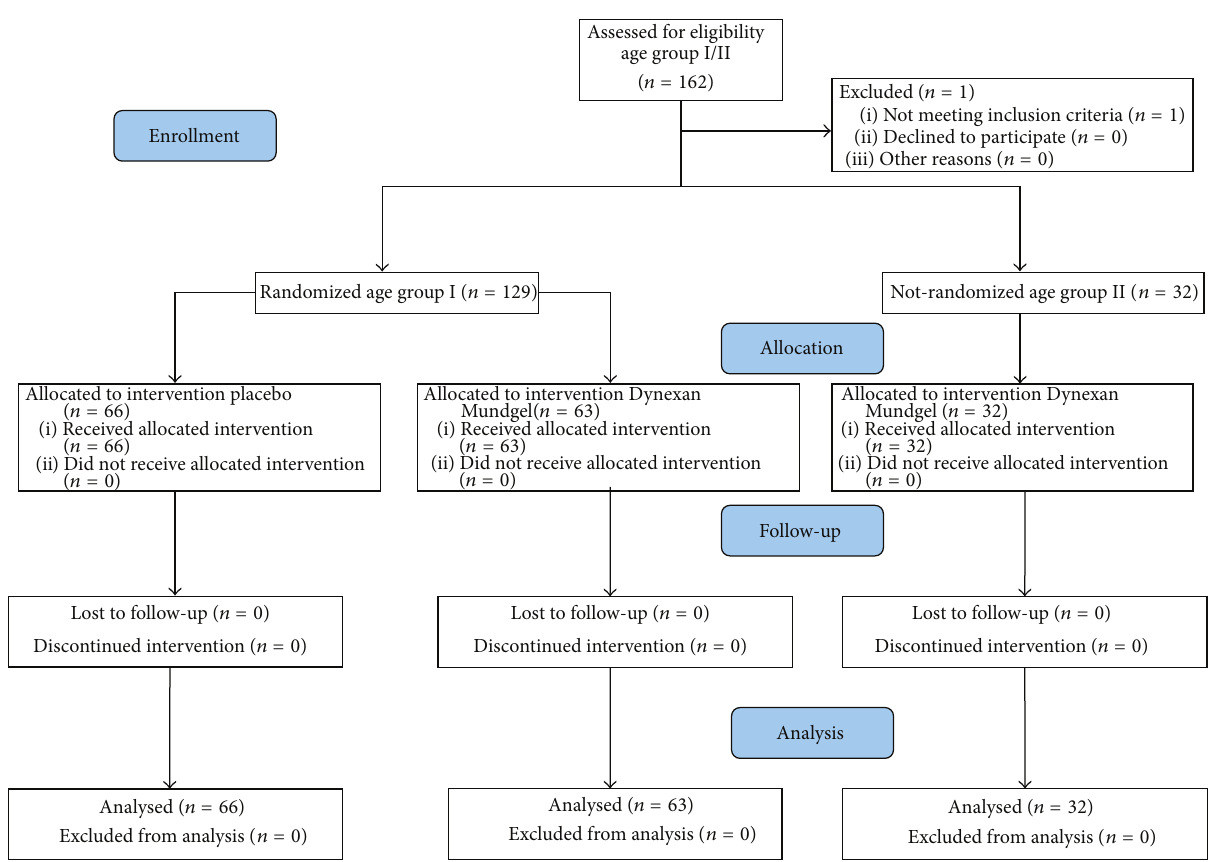
Figure 2: Disposition of study